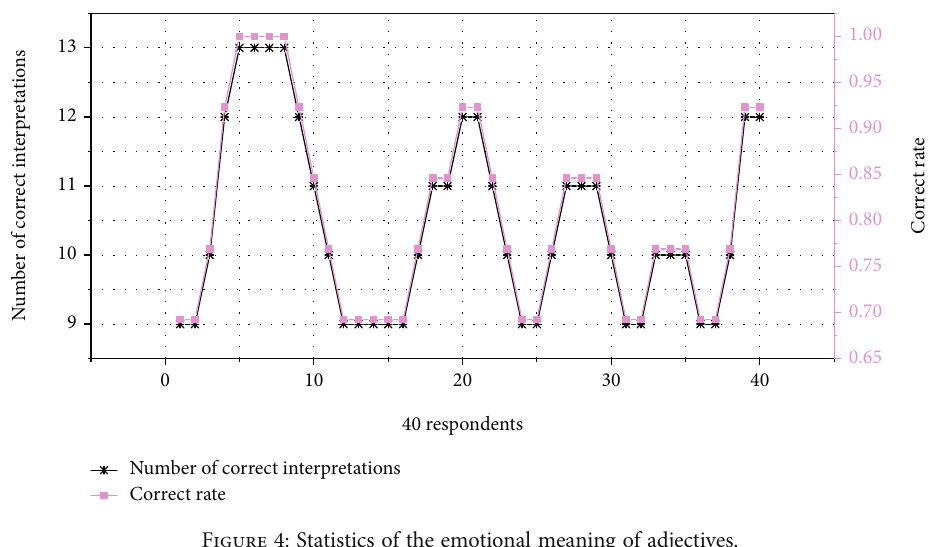
Figure 4: Statistics of the emotional meaning of adjectives. Table 2: Vocabulary emotion correction types and frequency of use by elementary Chinese as second language learners. Correction type